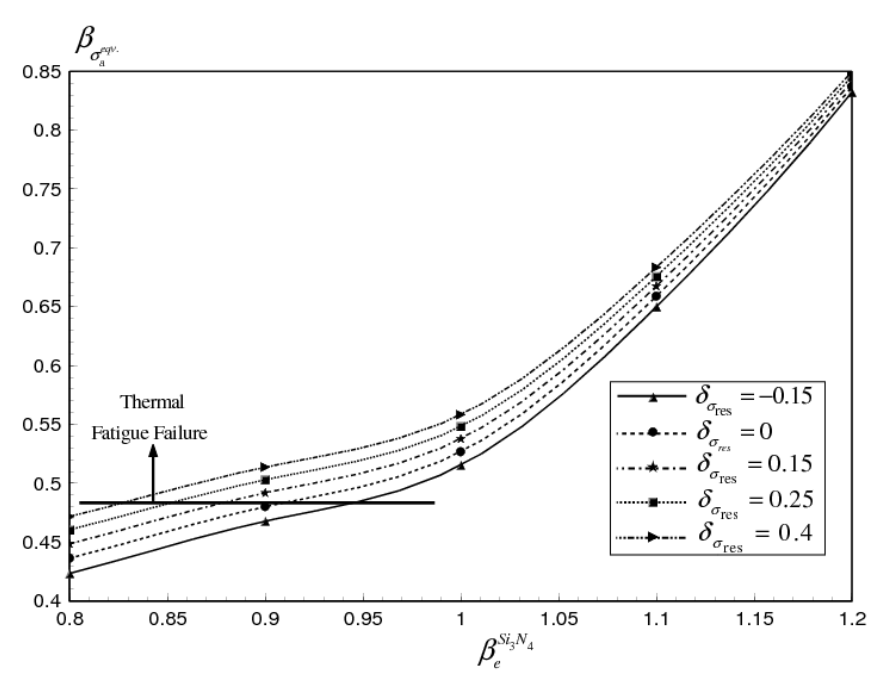
Figure 13. Effect of the variation of the coefficient of thermal expansion and deposition residual stress